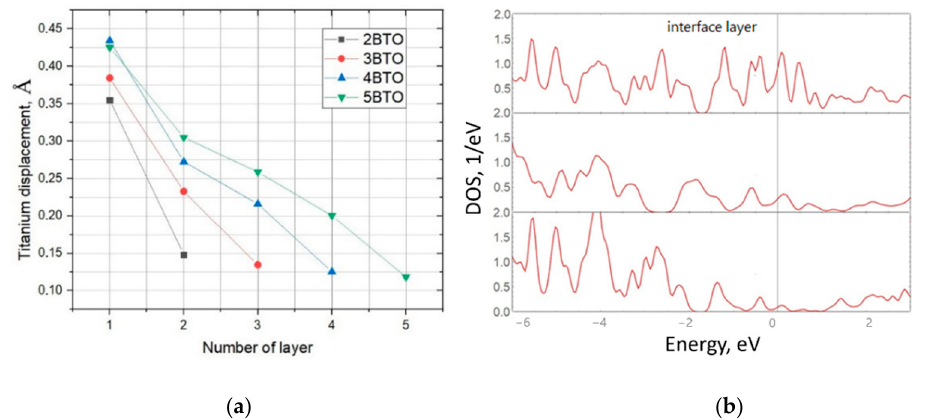
Figure 3. ( a ) The graph shows the dependence of the displacement of titanium atoms with respect to the oxygen plane on the BTO layer number for all obtained structures containing n -layers, where n = 2–5. The “1” denotes the interfacial layer, whereas “5” is the surface layer of the 5BaTiO 3 /Si heterostructure. ( b ) The layered density-of-states spectrum for a silicon wafer is presented. The first spectrum was compiled for the interface layer; that is, the layer at the silicon-BTO interface, then in turn for the layers to the center of symmetry of the structure.